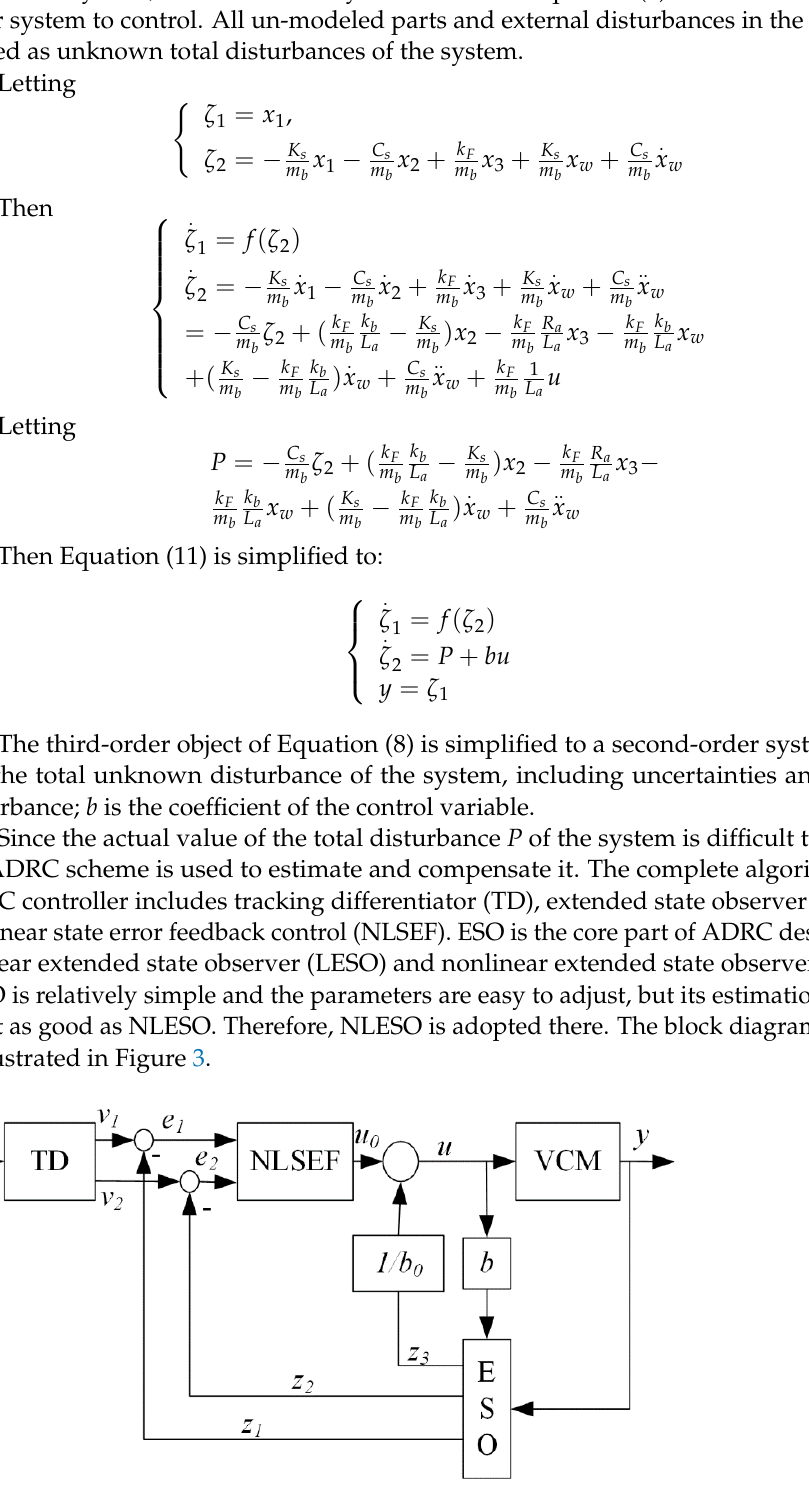
Figure 3. Block diagram of ADRC.